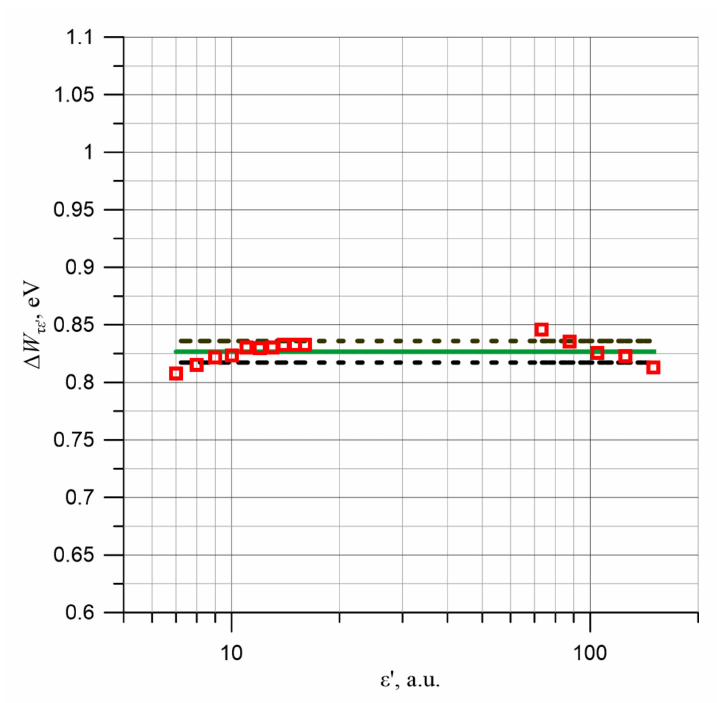
Figure 7. Relaxation time activation energy values ε (cid:48) determined for 15 permittivity values from Figure 3, mean value and mean value ± uncertainty of